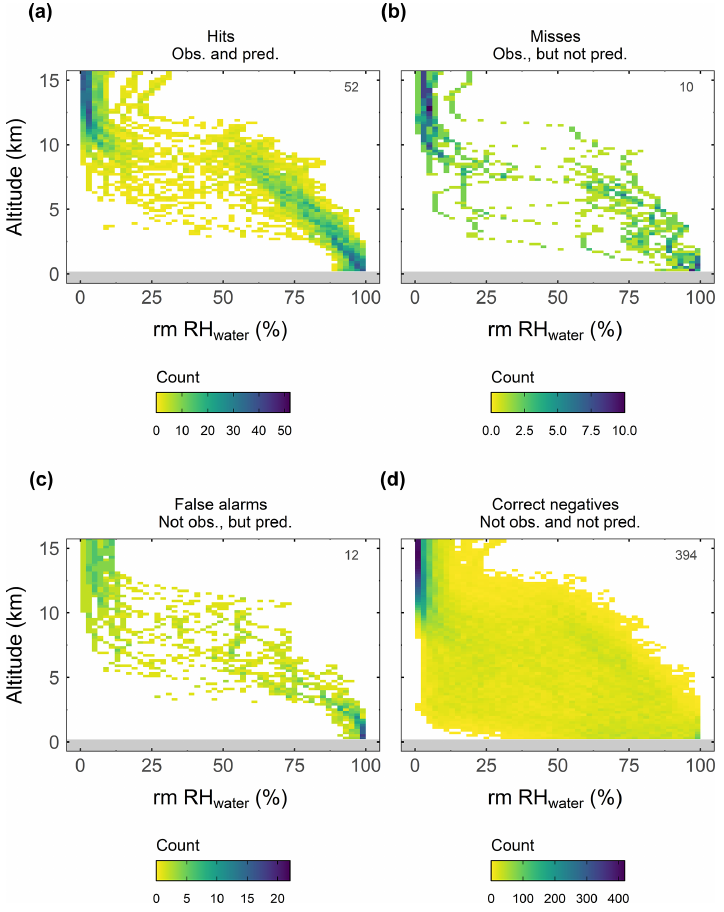
Figure A6. Same plot as Fig. 7, but for RH water .